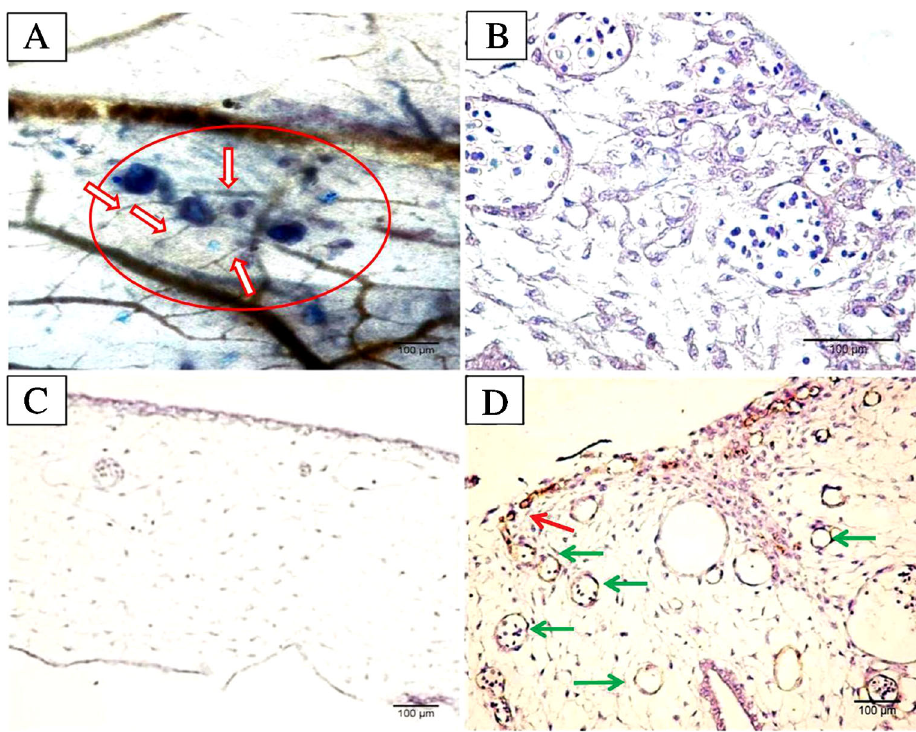
Figure 2. Assessment of chick embryo chorioallantoic membrane 24 h post-inoculation of P1.HTR cells. Mast cells were grouped around the main vessels (red circle) and a high density of small blood vessels convergent to mast cell clusters was observed ( A , white arrows, Alcian blue/safran method on uncut membrane). Histology of the chorioallantoic membrane 24 h post-inoculation ( B ). Note a high density of split small perfused and unperfused blood vessels in treated specimens compared to normal chick embryo chorioallantoic membrane ( C ). Immunostaining with FVIII-related antigen highlighted a heterogenous distribution of a positive reaction in endothelial cells from newly formed blood vessels in treated specimens. Note the homogeneous intense positive reaction in the capillary plexuses beneath the chorionic epithelium (red arrow). Weak or moderate expression of FVIII-related antigen in the newly formed perfused and unperfused blood vessels from chick chorioallantoic membrane after mast cell inoculation (green arrows) ( D